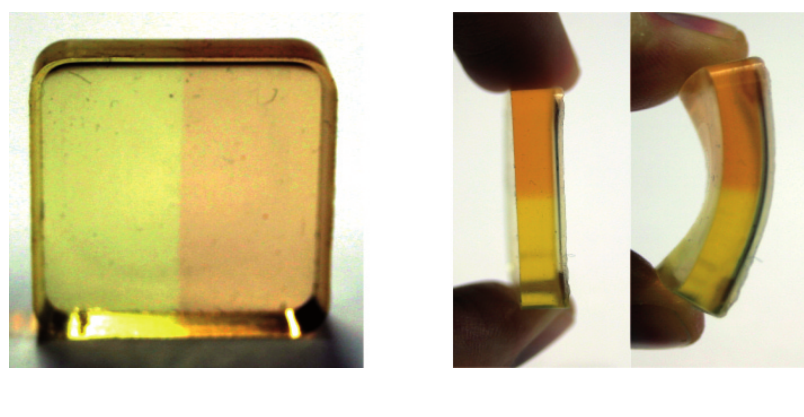
Figure 11. OSO embedded in PDMS. The right half of the sample was irradiated by white light of a halogen lamp for demonstration of the